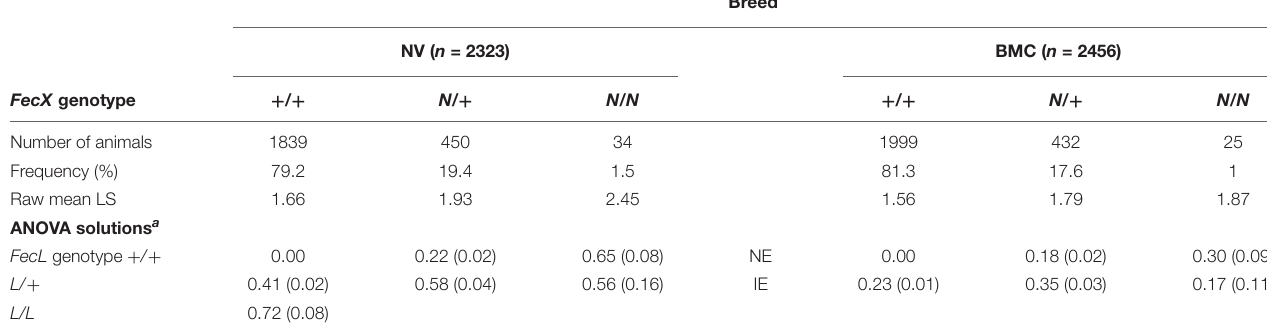
TABLE 4 | FecX N frequencies and effects on LS in NV and BMC